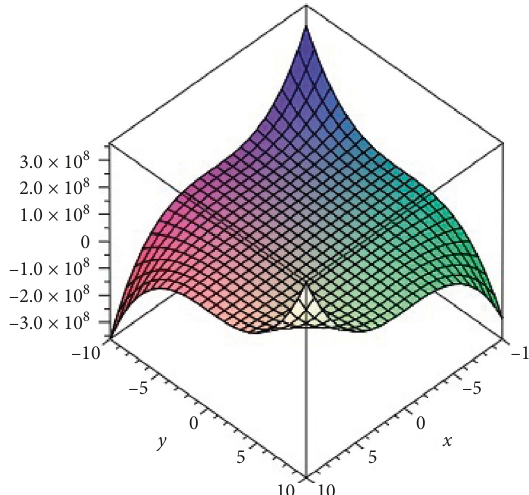
Figure 2: The 3D plot of M-polynomial of the benzene ring embedded in the P-type surface